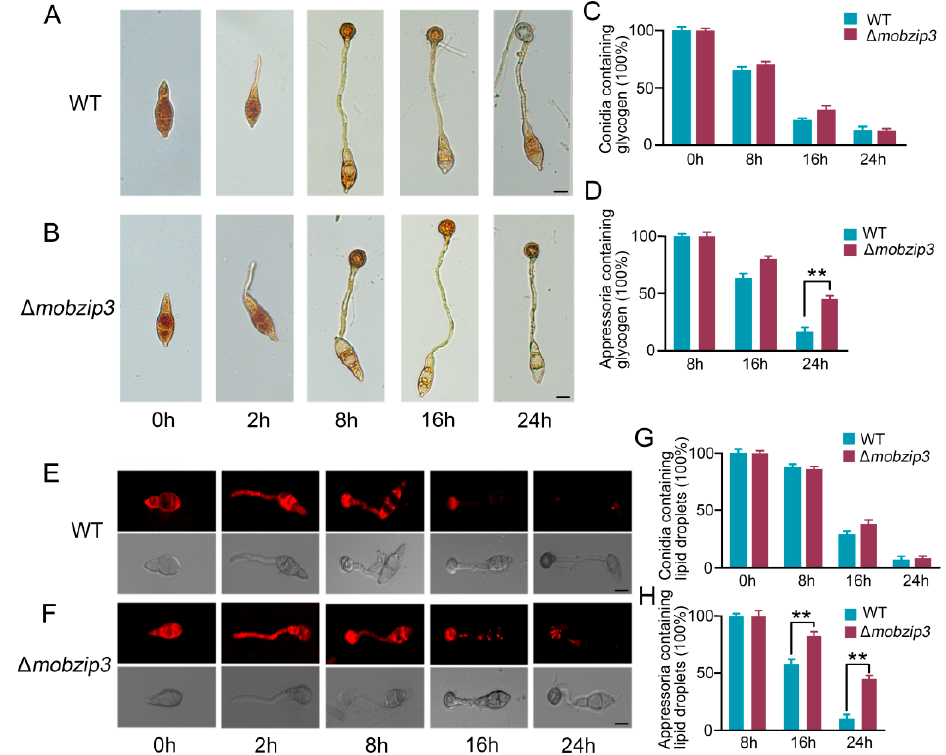
Figure 4. MoBZIP3 affects utilization of glycogen and lipid droplets in appressorium. Images showing the distribution of glycogen in WT ( A ) and ∆ mobzip3 ( B ) during appressorium development. Bar = 5 µ m. Samples were stained with KI/I2 solution. The percentage of glycogen in conidia ( C ) and appressoruin ( D ) during appressorium development. Error bars represent the standard deviation. Significant differences of Δ mobzip3 compared with the WT strain were estimated by students t test, n ≥ 50 cells, ** p < 0.01. Images showing the distribution of lipid droplets in WT ( E ) and Δ mobzip3 ( F ) during appressorium development. Samples were stained with Nile red and observed with fluorescence microscopy. The lipid droplets show a red signal fluorescence. Bar = 10 µ m. The percentage of lipid droplets in conidia ( G ) and appressoruin ( H ) during appressorium development. Error bars represent the standard deviation. Significant differences of ∆ mobzip3 compared with the WT strain were estimated by Student’s t -test, n ≥ 50 cells, ** p <